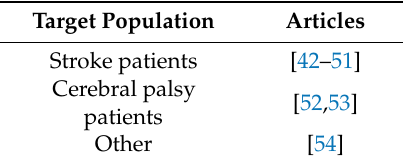
Table 2. Target population of research on